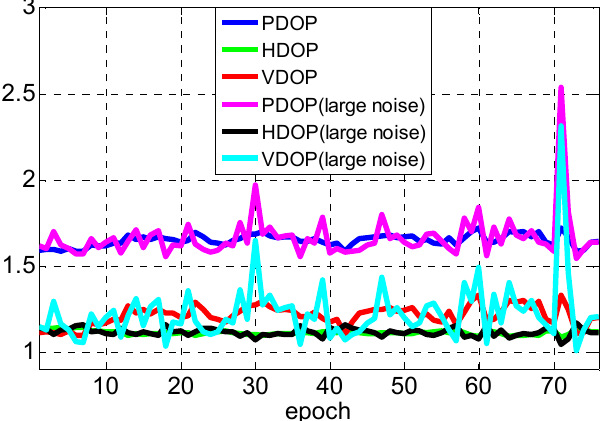
Figure 14. The average PDOP, HDOP and VDOP for each set of tests.